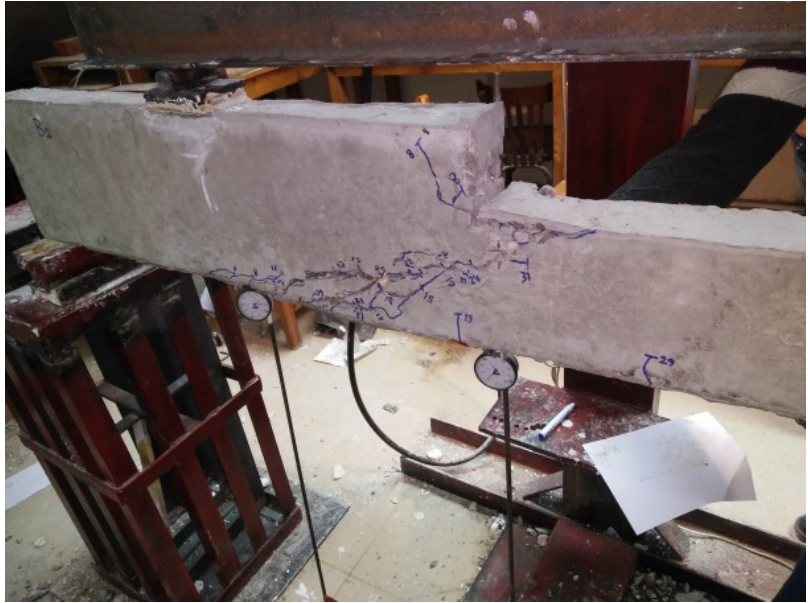
Figure 12. Crack pattern of beam B2 *.